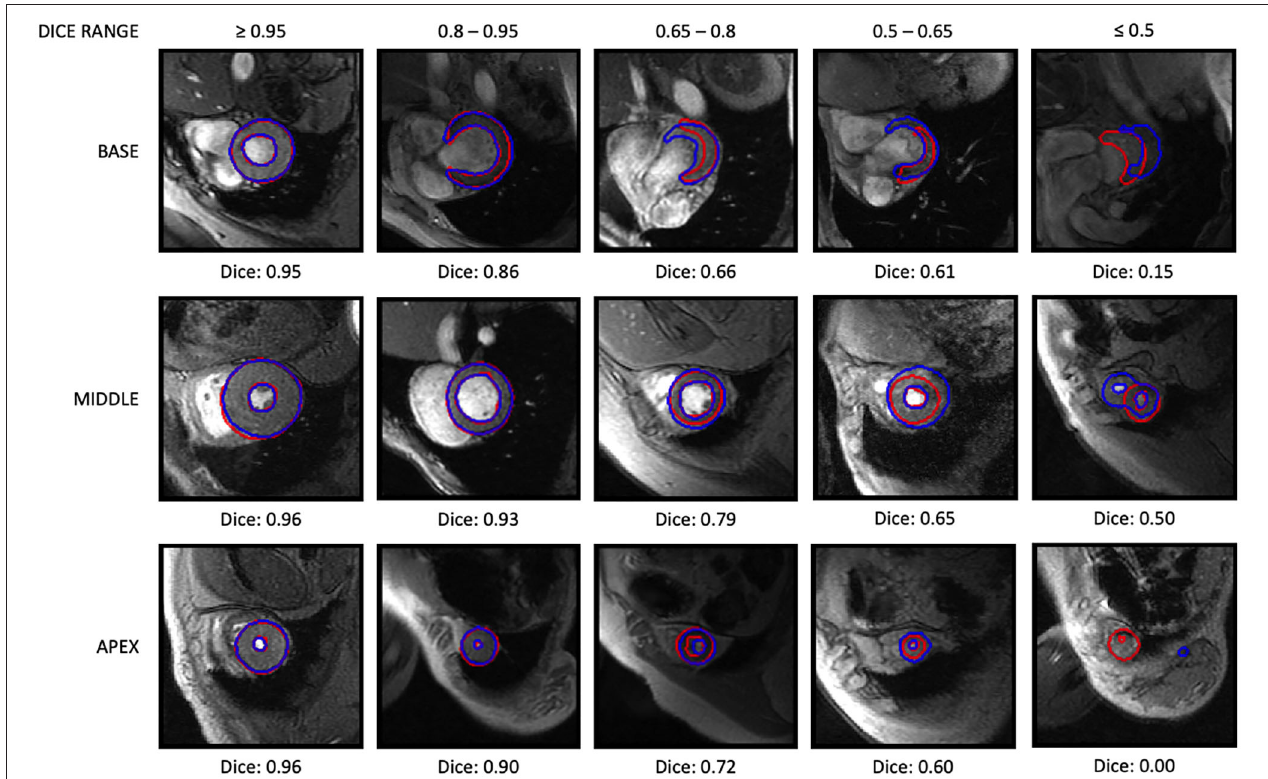
FIGURE 5 | Examples of short axis segmentation network results. Top row, base; middle row, mid-ventricle; bottom row, apex. Manual contours are in red while automated contours are in blue. A range of Dice score results are shown.